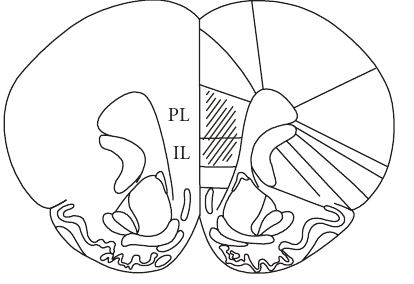
Figure 1: Recording sites. Single units were recorded in the prelim- bic (PL) and infralimbic (IL) cortices.